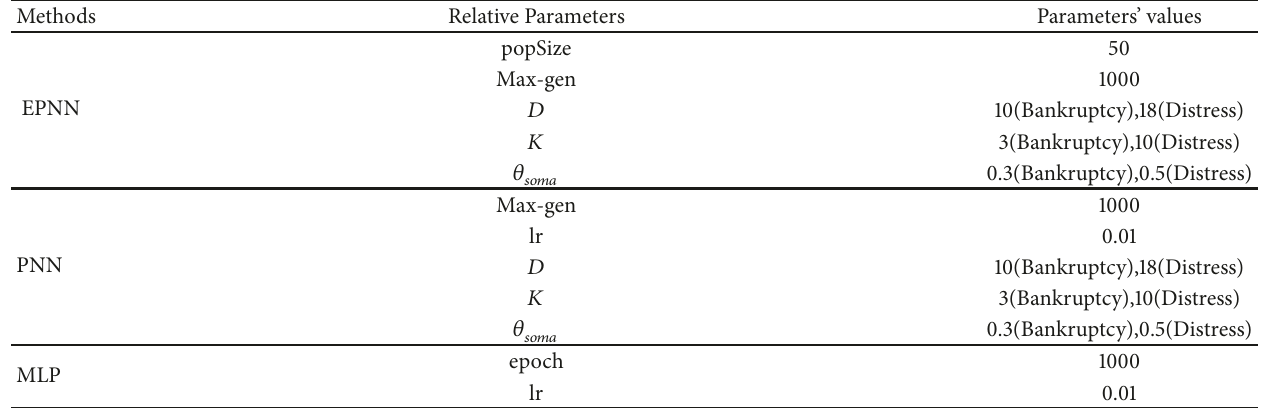
Table 5: Initial Parameters of the algorithms in